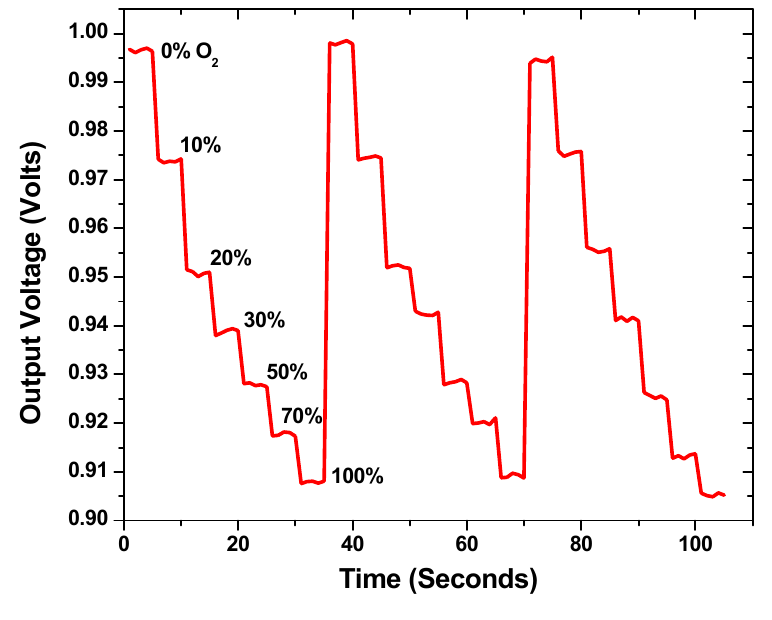
responsive xerogel sensor materials. 2